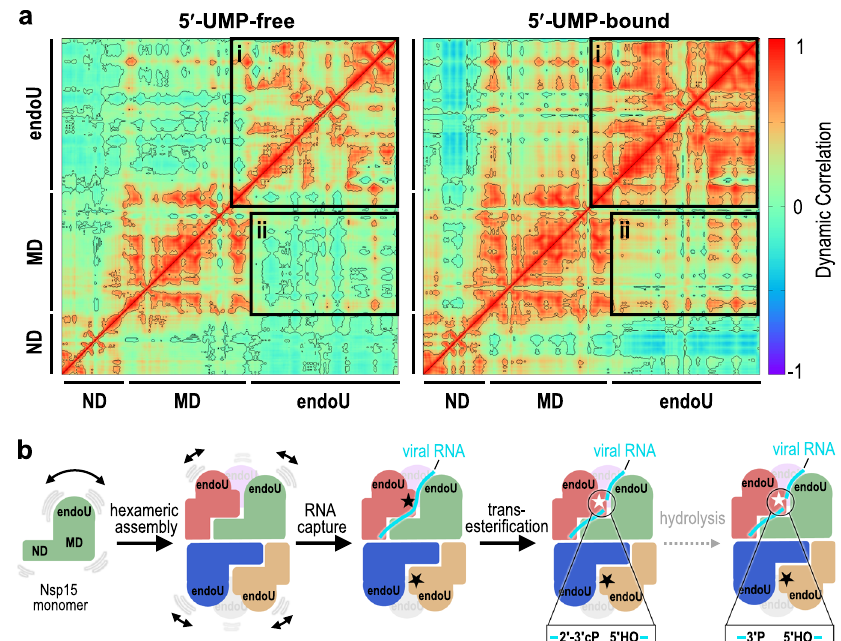
Fig. 6 Molecular dynamics reveal UMP locks the endoU domain. a Dynamical cross-correlation matrix (DCCM) analysis of a 5 ′ -UMP-bound protomer and its 5 ′ -UMP-free form from hexamer systems. Both inter- and intra-domain positive correlations are signi fi cantly enhanced due to 5 ′ -UMP binding. The correlations were calculated from the equally spaced 100-con fi gurations extracted from the last 500 ns of each simulation. Black boxes highlight the positively correlated motions between the endoU domains within the hexameric assembly (box i) and the endoU domain relative to the N-terminal half of the protomer (box ii). b Cartoon illustrating the dynamics of Nsp15 and the mechanism of RNA cleavage. Monomeric Nsp15 is stabilized by the formation of a hexameric assembly. In the absence of ligand the endoU domain exhibits conformational dynamics; however, upon binding to the RNA the endoU domain becomes stabilized. The fi xed endoU active site cleaves viral RNA and primarily generates products with a cyclic